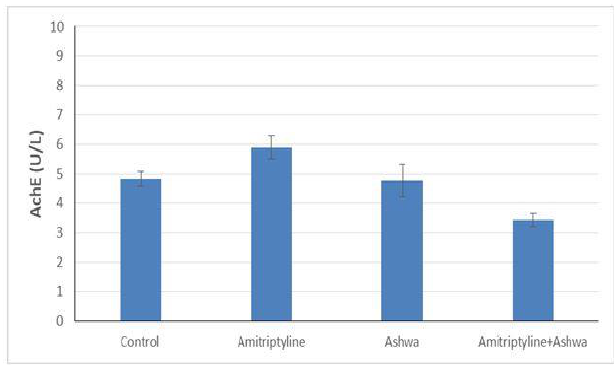
Fig.3: The levels of Acetylcholine esterase enzyme(AchE) at day 7 measured in (U/L).